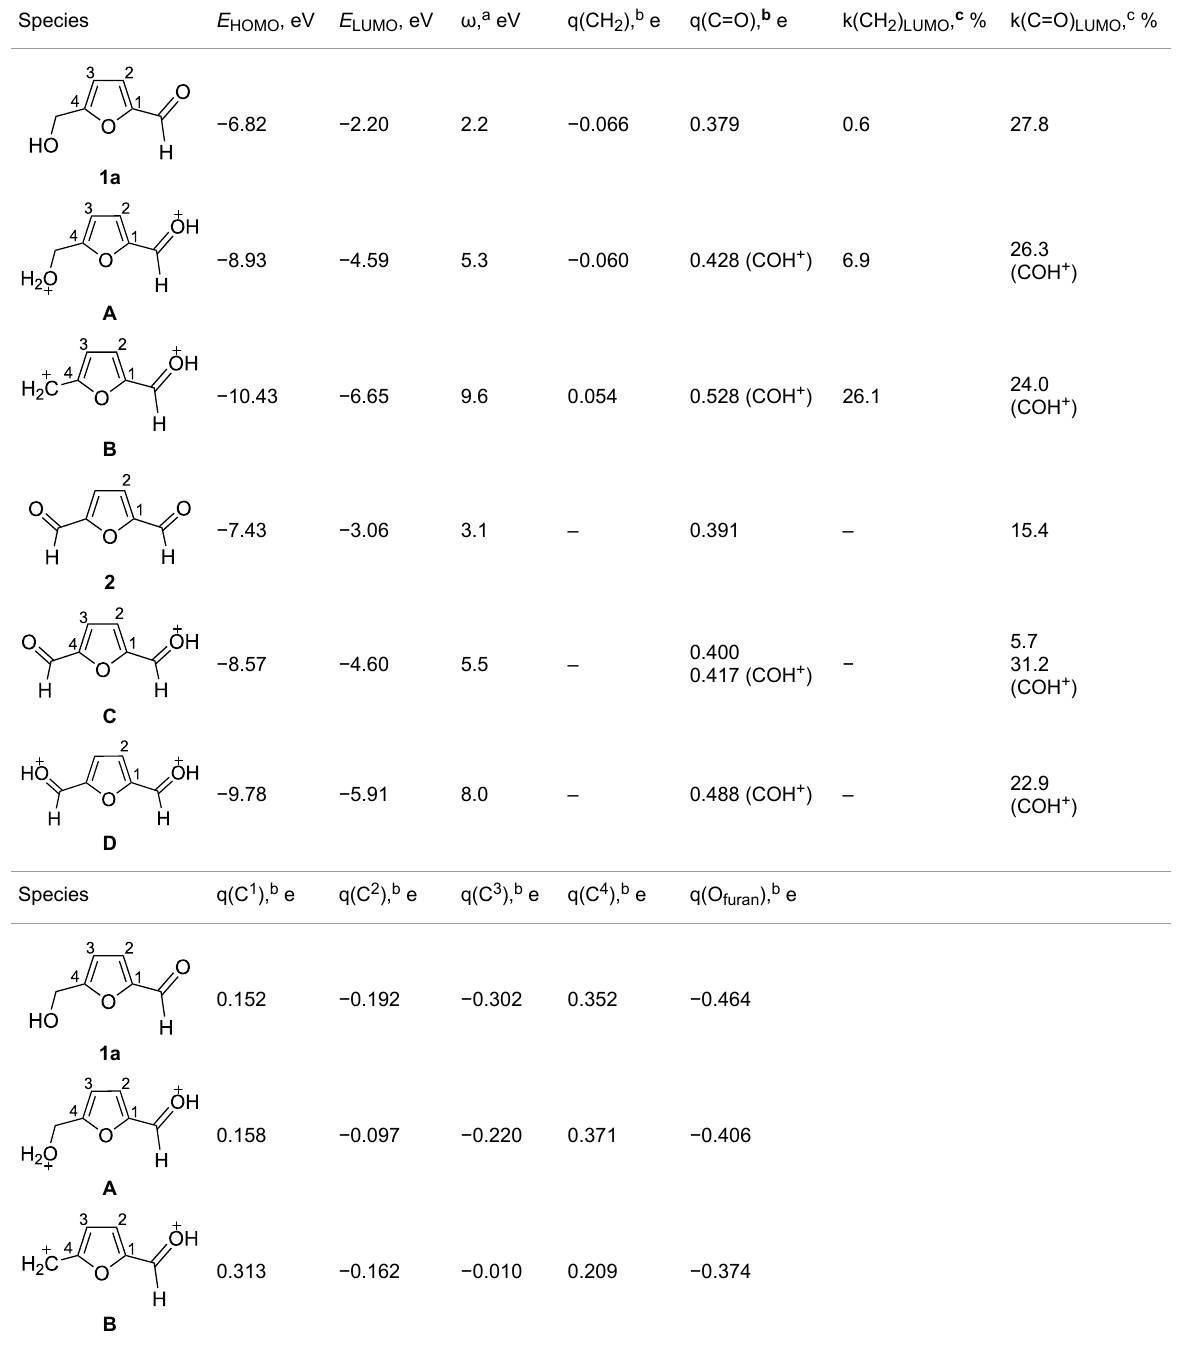
Table 1: Selected electronic characteristics (DFT calculations) of starting furans 1a , 2 and cationic species A , B , C , and D .